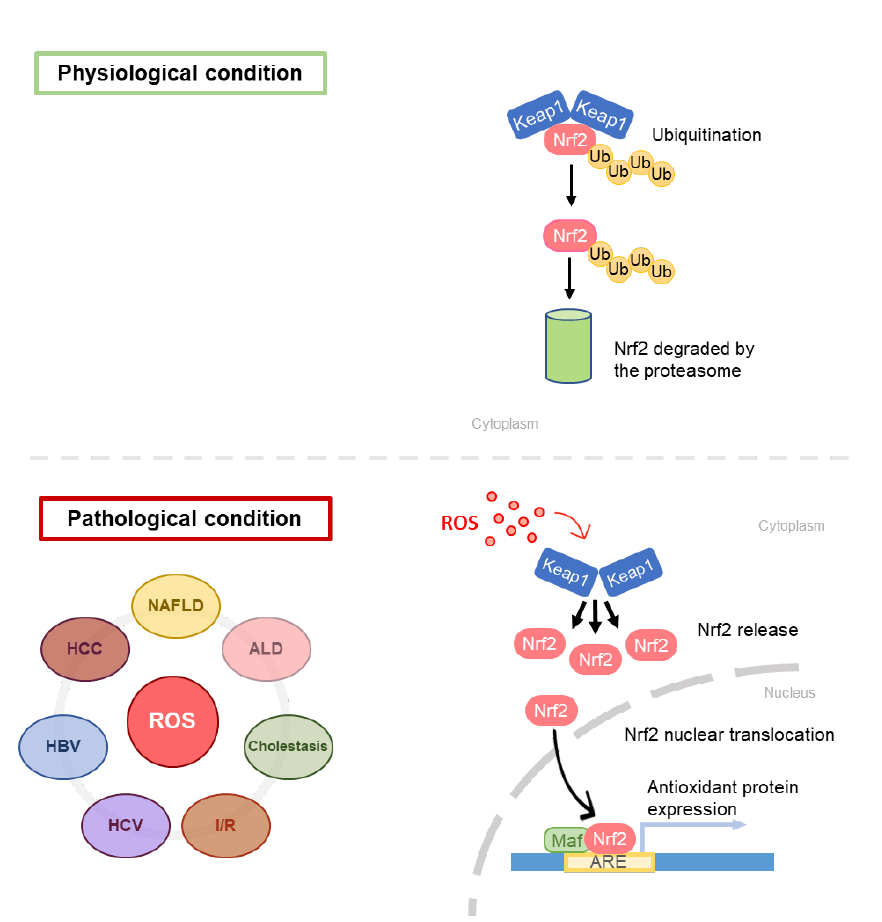
Figure 6. Schematic representation of Nrf2 pathway in different liver diseases. ARE, antioxidant response elements.